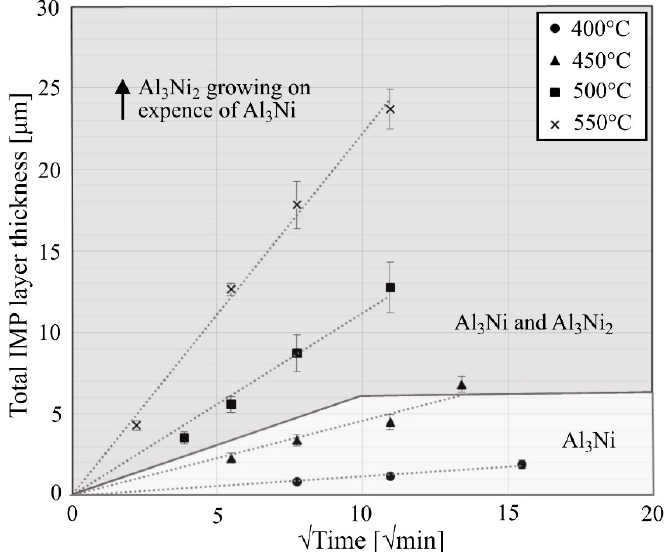
Figure 5. Thickness of the formed intermetallic phases (IMP) layer as a function of the square root of heat treatment time. The different grey-scale colored areas highlights where the IMP layer only consisted of one phase Al 3 Ni, and where two phases were clearly observed, Al 3 Ni and Al 3 Ni 2 . The error-bars show ± one standard deviation based on the obtained measurements.